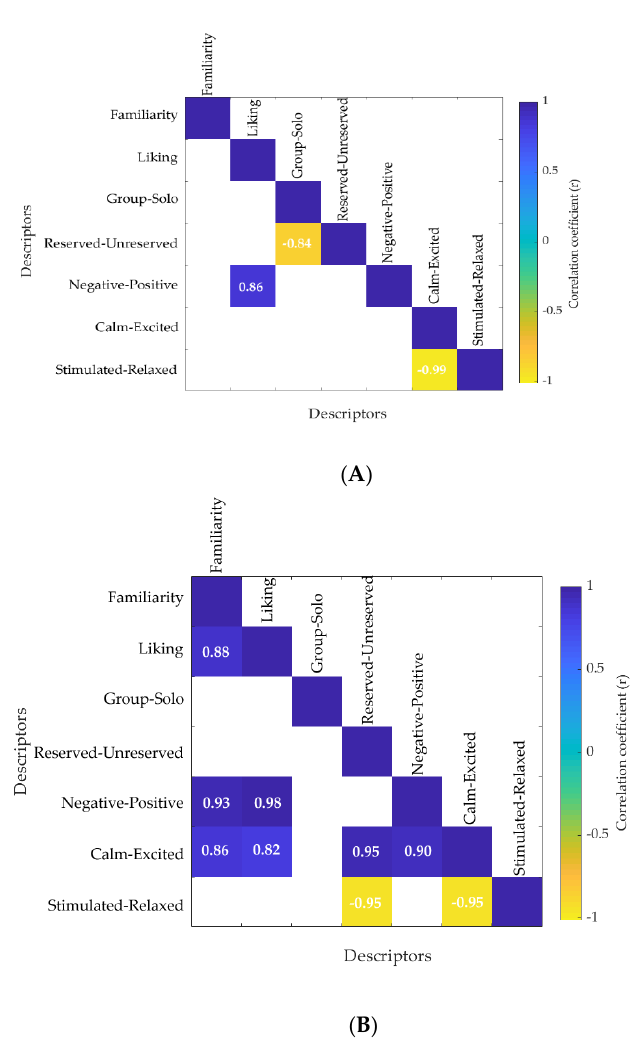
Figure 3. Correlation matrix showing the relationship between self-reported responses in ( A ) novel and ( B ) familiar packaging concepts. Only significant correlations are presented ( p < 0.05). The color bar represents the correlation coefficients in a scale from –1 to 1, where the blue end denotes the positive correlations and the yellow end represents the negative correlations.